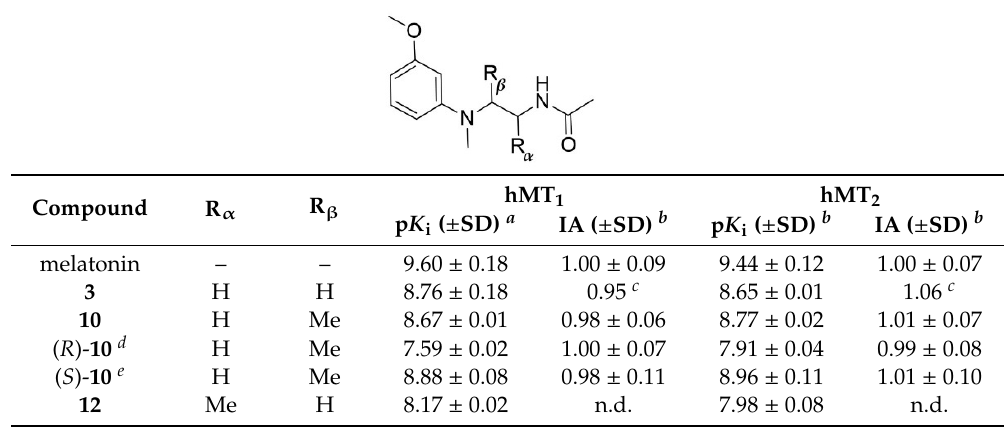
Table 1. Binding affinity and intrinsic activity of alpha- and beta-methyl N -anilinoethylamides for human MT 1 and MT 2 melatonin receptors.